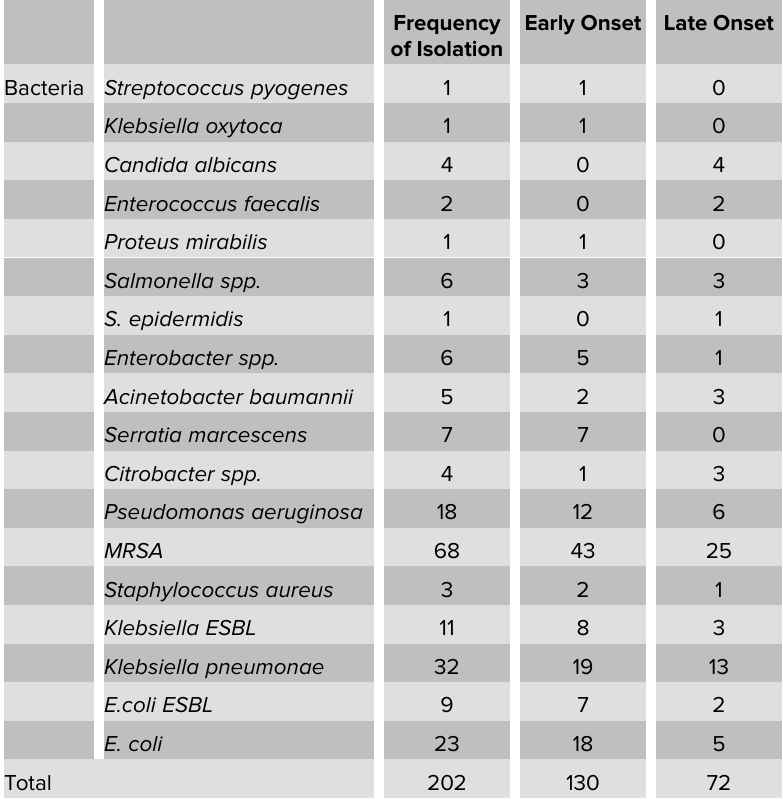
Table 1: Distribution of isolated organisms in an EOS and